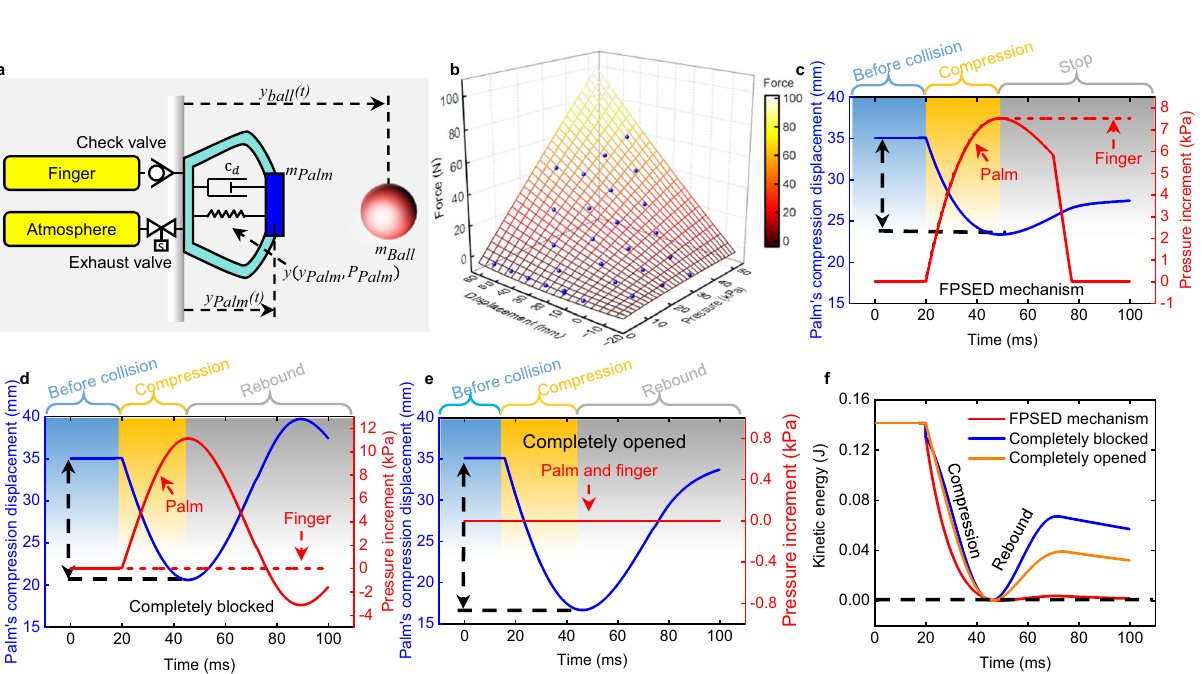
Fig. 2 | Simulation set-up and results for the multi-physics model coupling palm/ball dynamics along with the gas exchange. a Simulation set-up. b Fitted forces at different palm displacement and pressure data points. c FPSED mechan- ism. The check valve connects the palm and fi ngers for energy harvesting, and the controllable exhaust valve connects the atmosphere to dissipate the internal